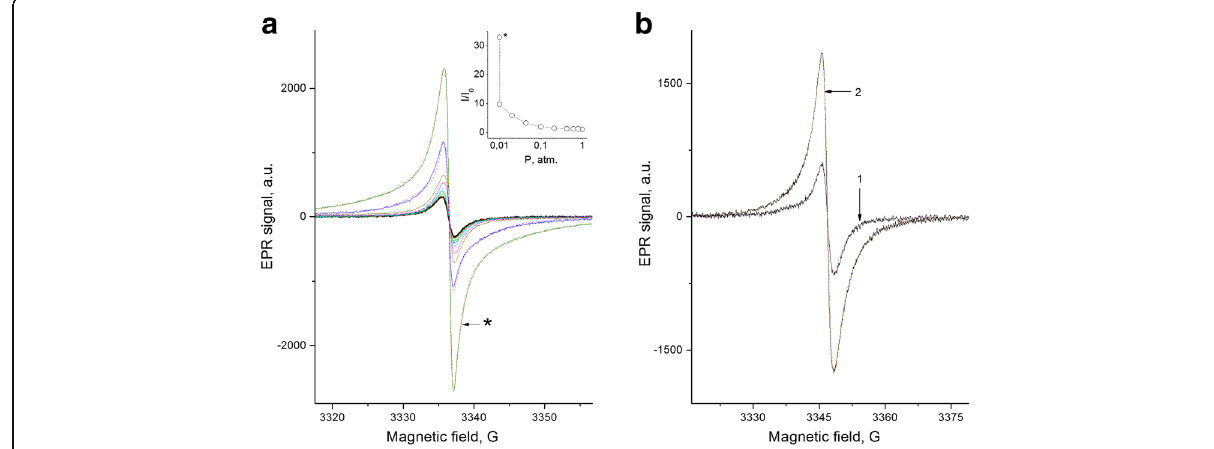
Fig. 2 EPR spectra of fullerene soot at the various oxygen content and composite PhC-2 + 3% fullerene soot. a. The magnitude of the pressure of residual atmospheres (from the small to the larger amplitudes of the EPR spectrum) at room temperatures of pumping out: 1; 0.8; 0.61; 0.42; 0.21; 0.1; 0.043; 0.02; 0.001 atm., * — pump. 0.5 h at 160 ° C, dash line — fitting by 3 Lorentzian. The insert: the dependence of the total intensity of the EPR spectrum on the oxygen pressure. * — pumping out 0.5 h at T = 160 °C. b. The composite PhC-2 + 3% fullerene soot (FS) before (1) and after (2) pumping out of the samples during 1 h at T = 160 ° C. Dashed lines — fitting (Table